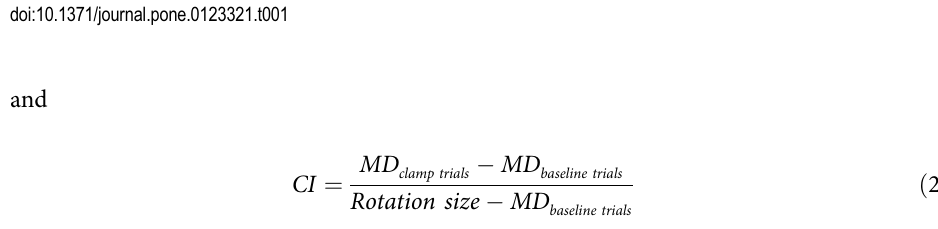
Table 1. Experimental protocol. Blockname # of Trials Visual FB Intro Familiarization 6 0° Baseline no FB 6 - Set 20 Baseline/Washout 60 0° Adaptation 60 -20° Exclusion/Inclusion 9 - Inclusion/Exclusion 9 - Set 40 Baseline/Washout 60 0° Adaptation 60 -40° Exclusion/Inclusion 9 - Inclusion/Exclusion 9 - Set 60 Baseline/Washout 60 0° Adaptation 60 -60° Exclusion/Inclusion 9 - Inclusion/Exclusion 9 - Visual feedback (FB) was either not present (-), veridical (0°) or rotated (20°, 40° or 60°). Each set was performed twice with alternating order of exclusion and